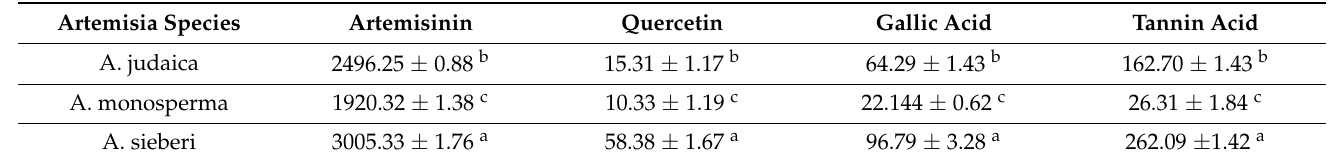
Figure 1. HPLC chromatograms: ( a ) artemisinin standard; ( b ) leaf extract. Table 3. Bioactive compounds (ART, quercetin, gallic acid, and tannic acid of Artemisia species ( µ